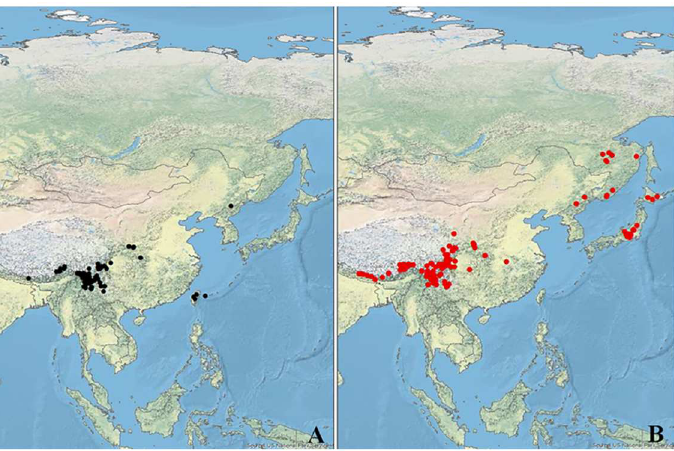
Fig 2. The geographic distribution of examined specimens of the two examined Hypogymnia species. A. Hypogymnia flavida ; B. Hypogymnia hypotrypa . Basemap source: U.S. NationalPark Service (NPS) Natural Earth physical map at 1.24 km per